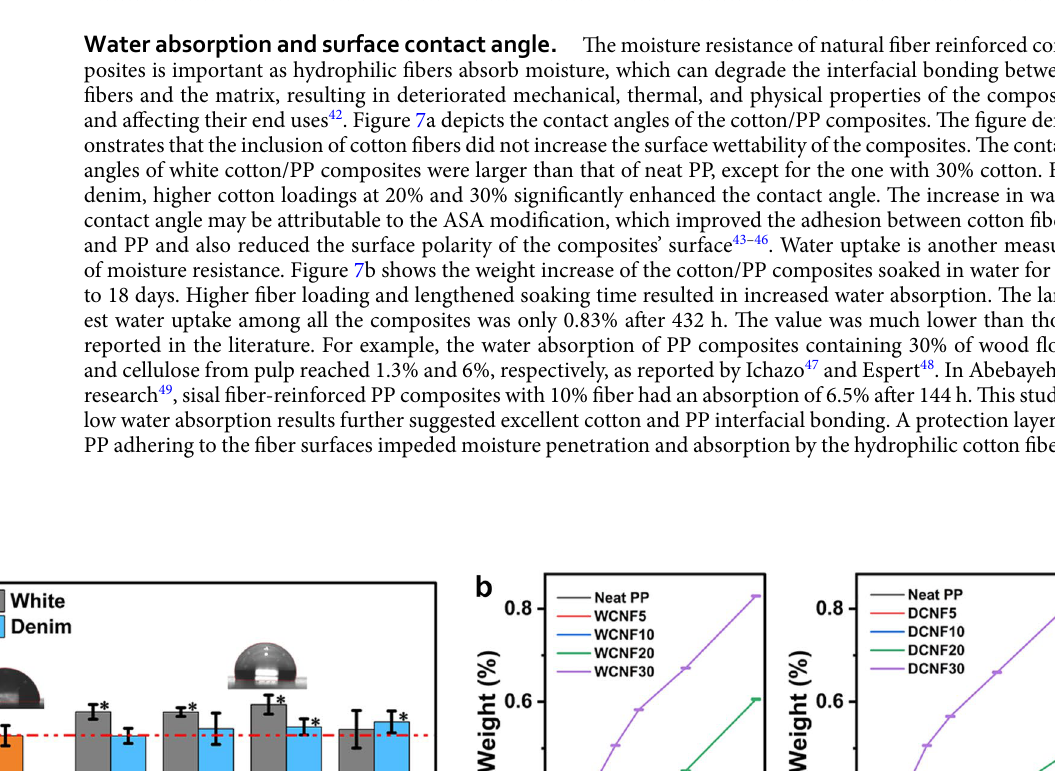
Figure 6. Impact fracture of 20% ASA-SMC denim cotton ( a ) and white cotton ( b ) composites. Peeled fibers at the fracture surface are circled and arrows point to broken fibers.